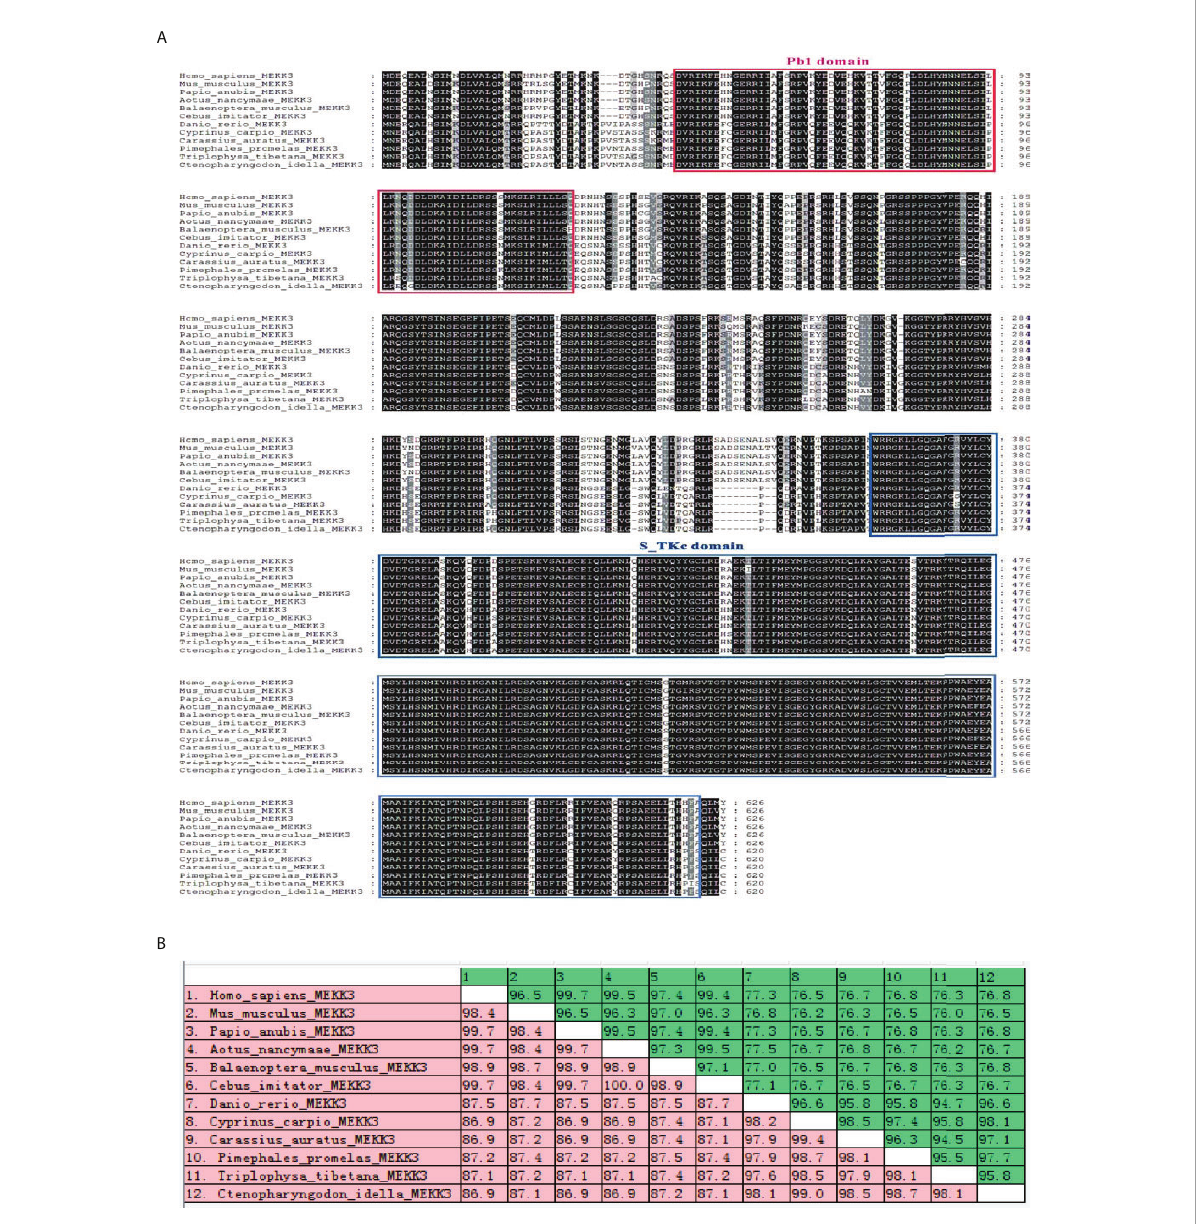
FIGURE 3 Multiple alignment of Ci MEKK3 with other reported MEKK3 from GenBank database. (A) Identical amino acids are shaded in black and similar amino acids are shaded in gray. The conserved PB1 domain and S_TKc domain are indicated by the red box and blue box, respectively. (B) The similarities (red) and identities (green) of amino acid sequences were analyzed using MatGAT2.02